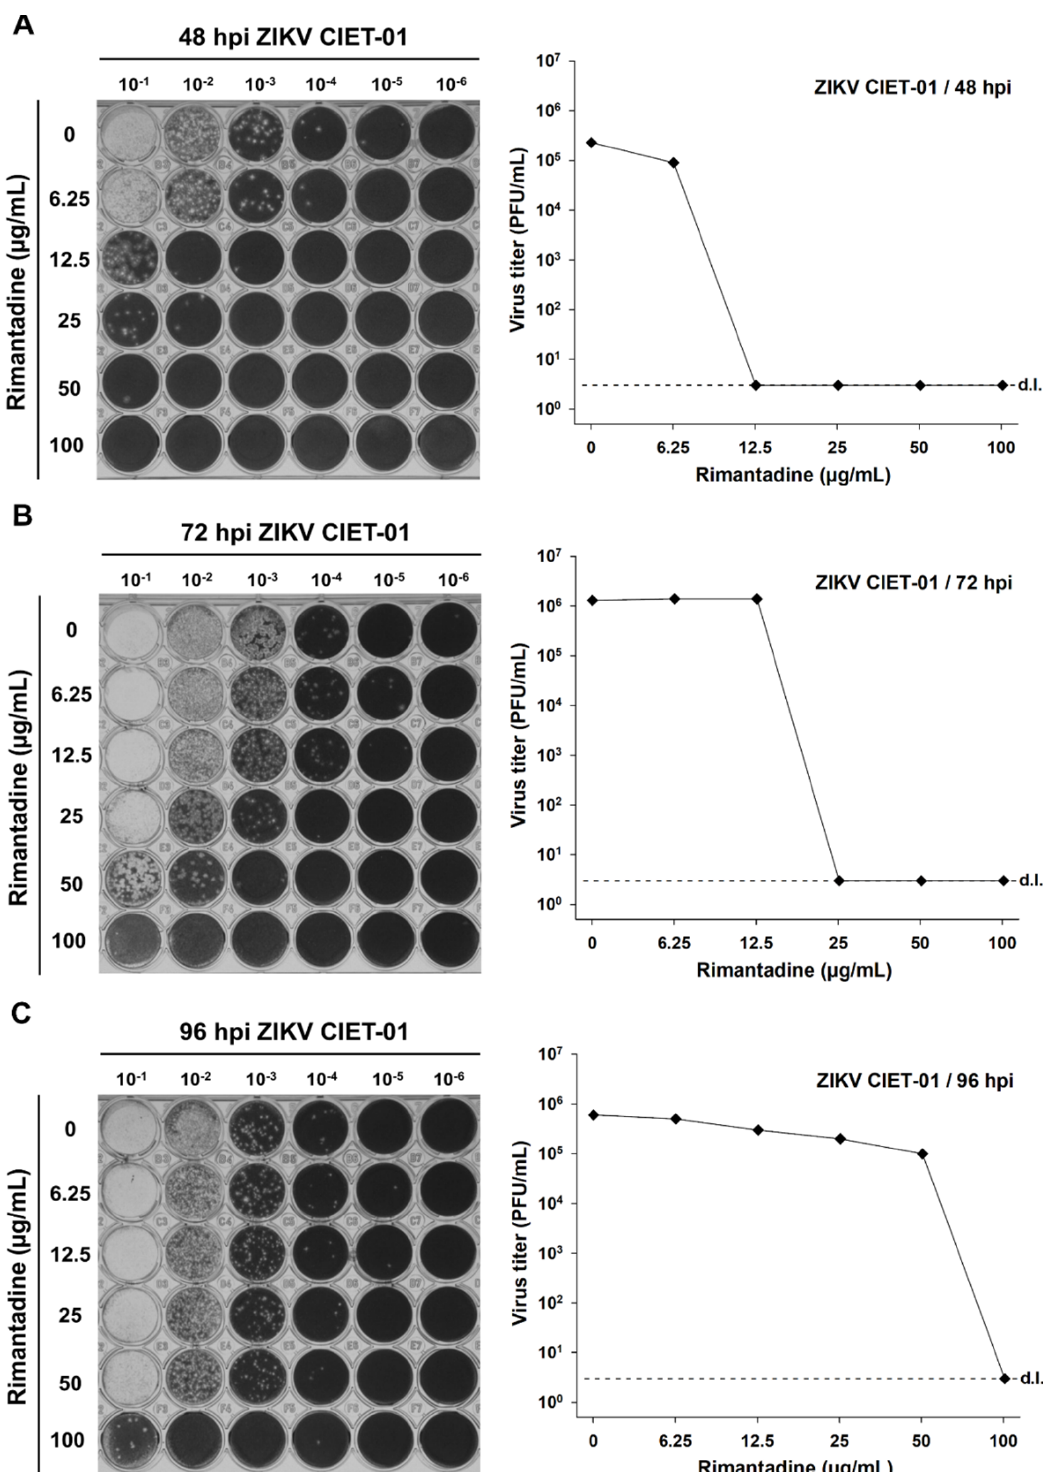
Figure 1. Amantadine hydrochloride suppresses the in vitro replication of a ZIKV clinical isolate. Virion production was quantified by plaque assays of culture supernatants of Vero cells treated with different concentrations of amantadine hydrochloride at 48 ( A ), 72 ( B ), and 96 ( C ) hours post-infec- tion (hpi) with ZIKV clinical isolate CIET-01 at an MOI of 0.1. Data from a single experiment are shown. d.l. = assay detection limit.